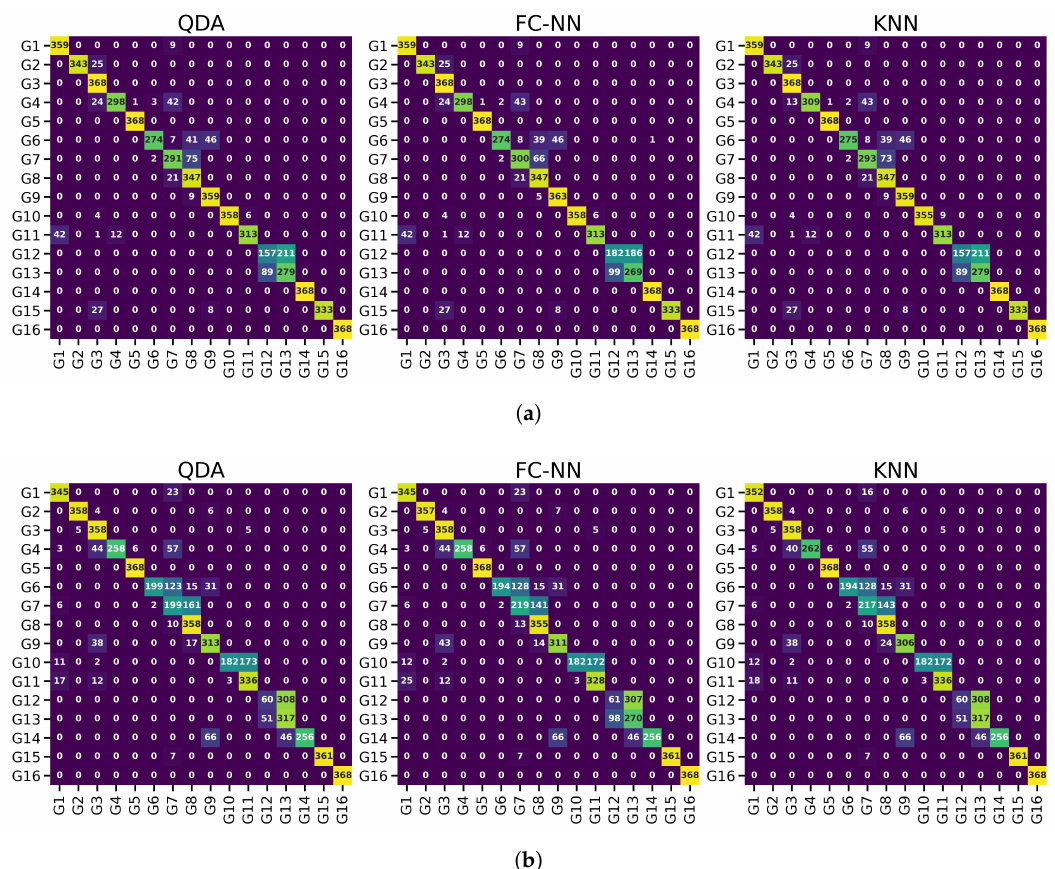
Figure 6. Confusion matrices for QDA, FC-NN, and KNN displaying per-class accuracy on the pipeline’s features using participant two’s both test sessions. ( a ) Confusion matrices using participant two’s first test session. ( b ) Confusion matrices using participant two’s second test